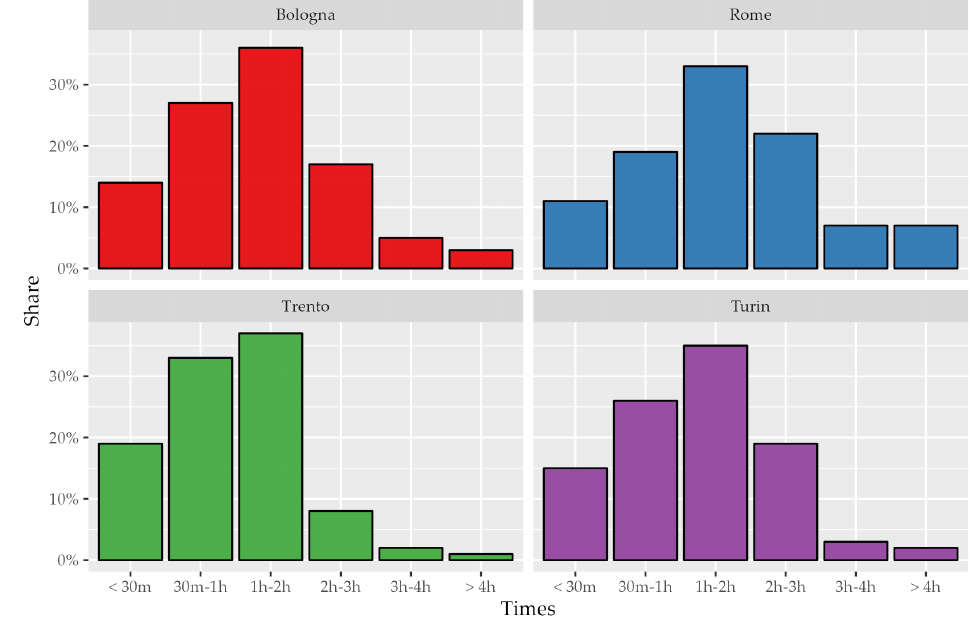
Figure 3. Daily commuting time of workers from the survey in the four